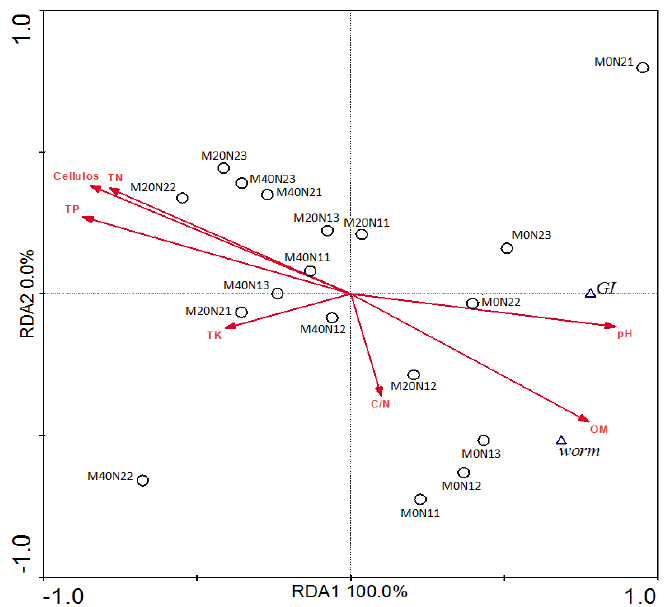
Figure 4. Redundancy analysis of the D_value of the weight of worms and germination rate to the environmental factors in the improved vermicomposting system (after 60